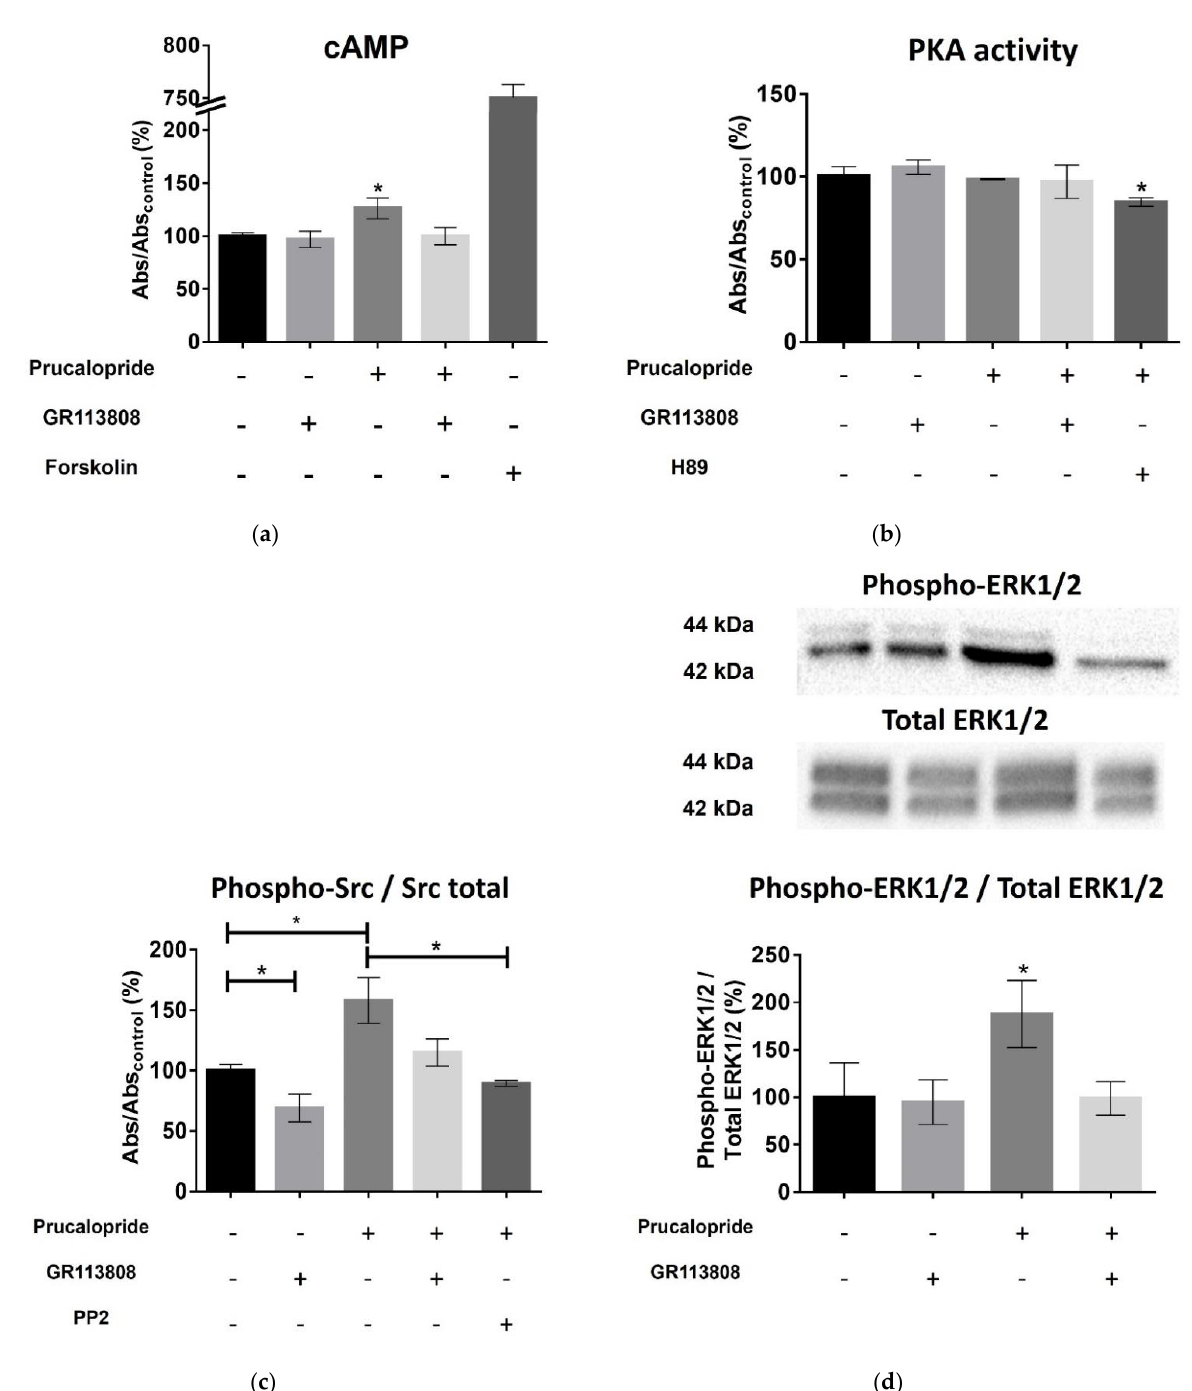
Figure 7. Identification of signaling pathways involved in the 5-HT 4 receptor effect on the blood–brain barrier. All cells were depleted of fetal bovine serum. ( a ) Stimulation of the 5-HT 4 receptor by a 15-min long prucalopride (10 µM) treatment results in an increase in intracellular cAMP concentration in the hCMEC/D3 cell line. This increase is prevented by GR113808. ( b ) The increase in cAMP does not translate into a significant increase in PKA activity at 24 h. ( c ) Treatment with prucalopride for 24 h induces Src phosphorylation. This effect is prevented by GR113808 and the Src inhibitor PP2. ( d ) Relative integrated density values of Western blot analysis assessing the effect of 24 h treatment of prucalopride (10 µM), GR113808 (1 µM) and GR113808 (1 µM) + prucalopride (10 µM) on ERK 1/2 phosphorylation in hCMEC/D3 cells show that prucalopride induces ERK 1/2; phosphorylation. Histograms represent means ± SEM from three independent experiments. * p <